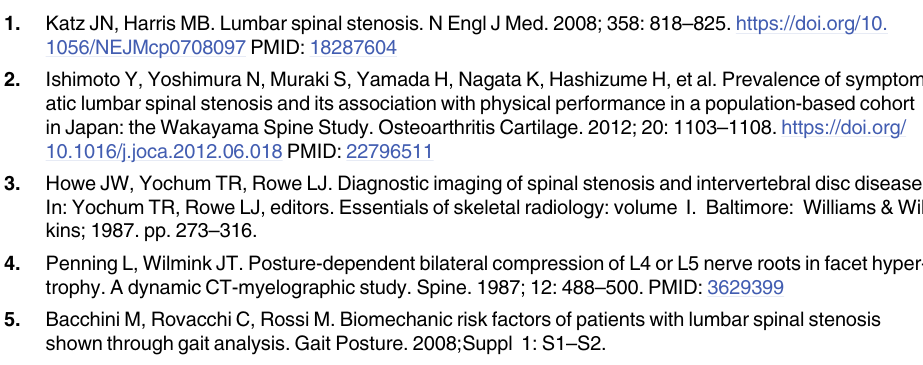
S1 Table. Data of the kinetic and kinematic